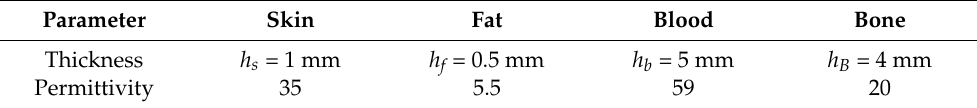
Table 1. Parameters of the studied Cole–Cole-based four-layers fingertip model.